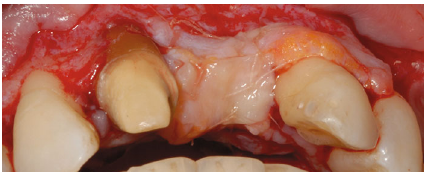
Figure 10: Sutured multilayered connective tissue graft (occlusal